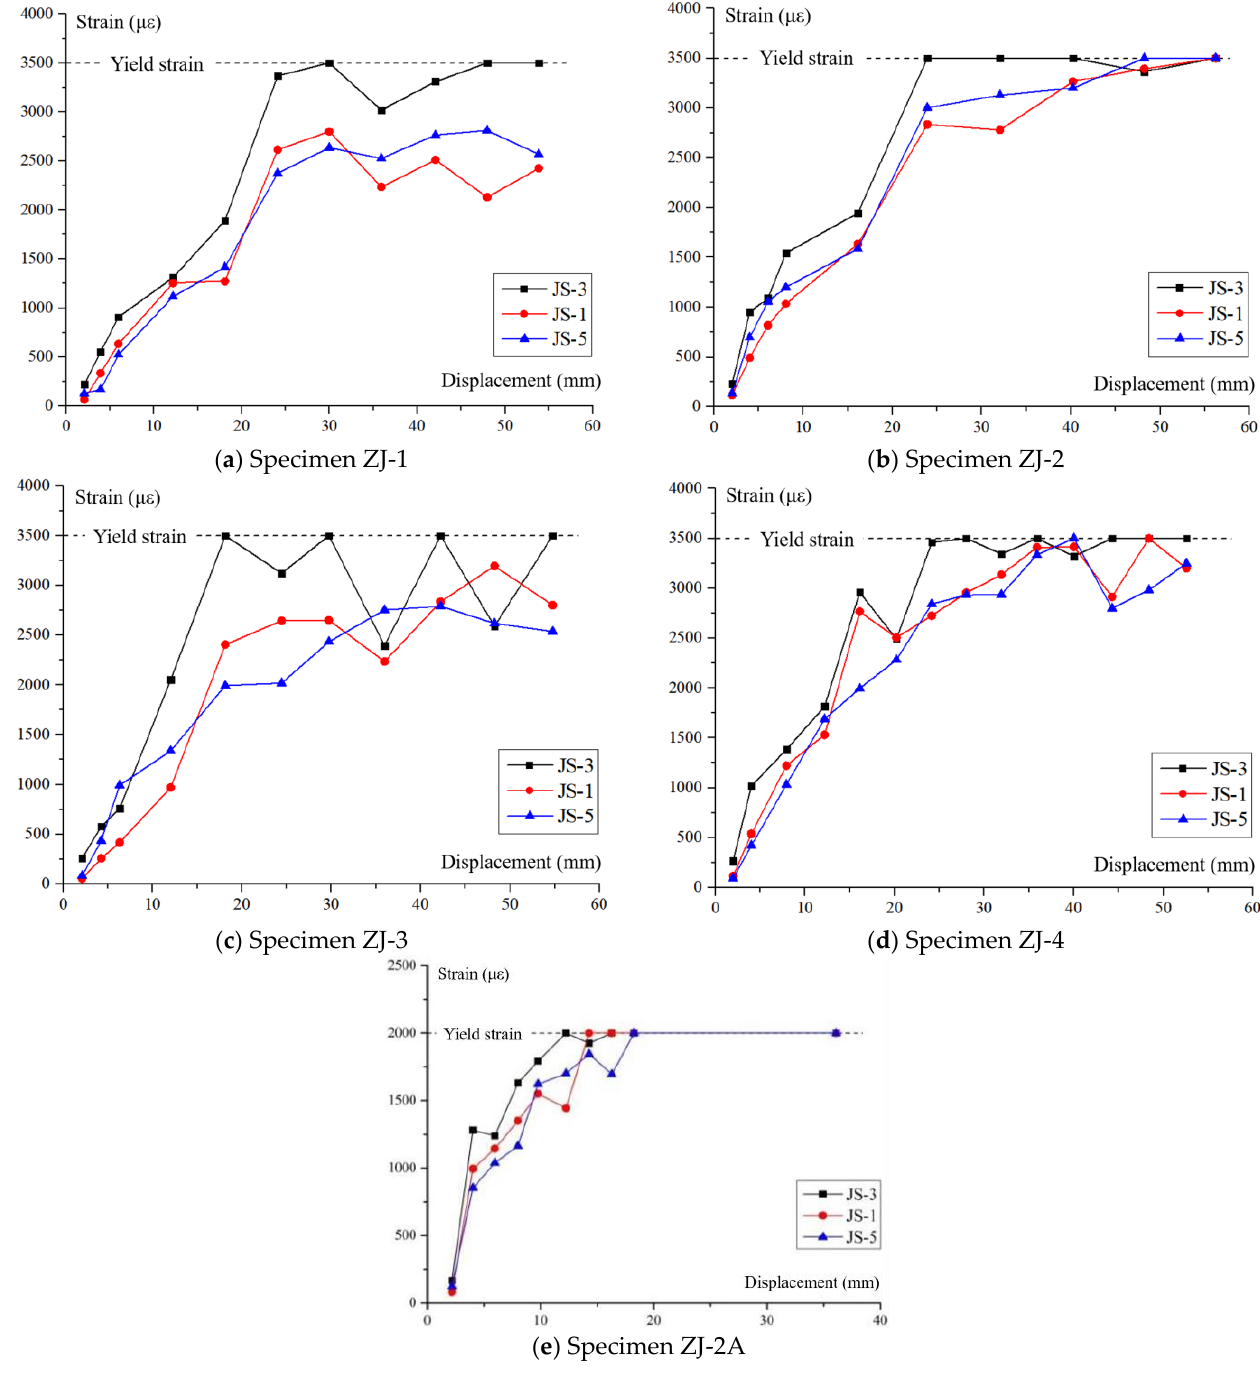
Figure 20. Stirrup strain of cruciform joints.